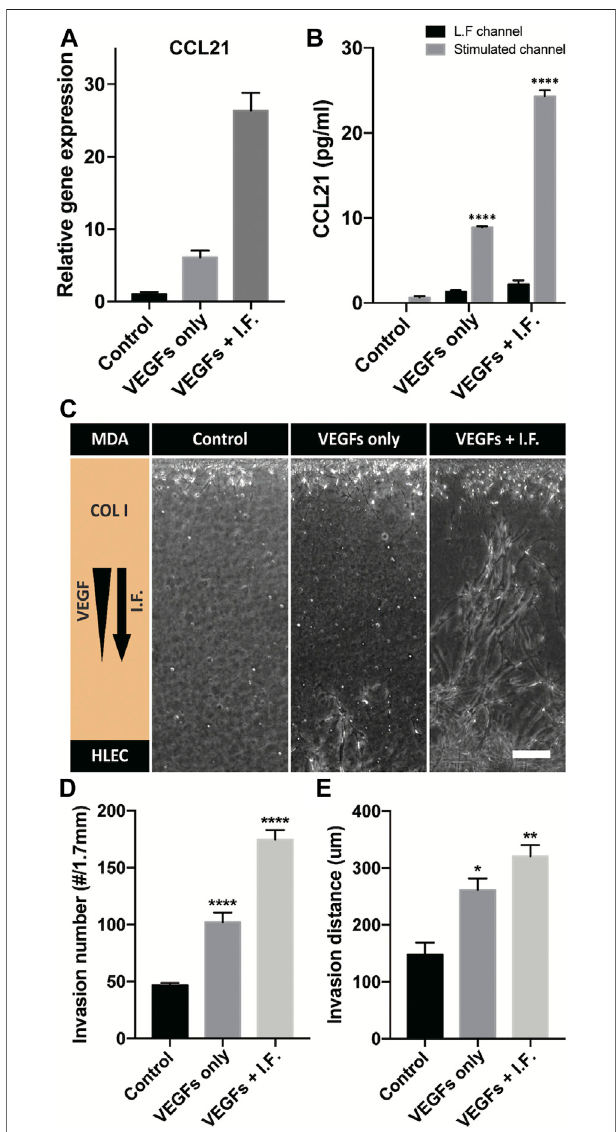
FIGURE 5 | CCL21 expression and coculture model of a high-invasive cancer cell and a lymphatic endothelial cell. (A) Gene-level expression of CCL21 on lymphatic endothelial cells under lymphangiogenic factors. (B) CCL21 expression using ELISA in a cell-cultured channel and the lymphangiogenic factor channel (**** indicates p < 0.0001, and CCL21 expressions are compared with control in L.F. channel). (C) Micrograph of lymphatic sprouting and cancer cell invasion under lymphangiogenic factors. Scale bar is 200 μ m. (D, E) Quanti fi cation of cancer invasion in terms of (D) invaded cell number and (E) invasion distance. The results are compared with control (*, **, and **** indicate p < 0.05, p < 0.001, and p < 0.0001).